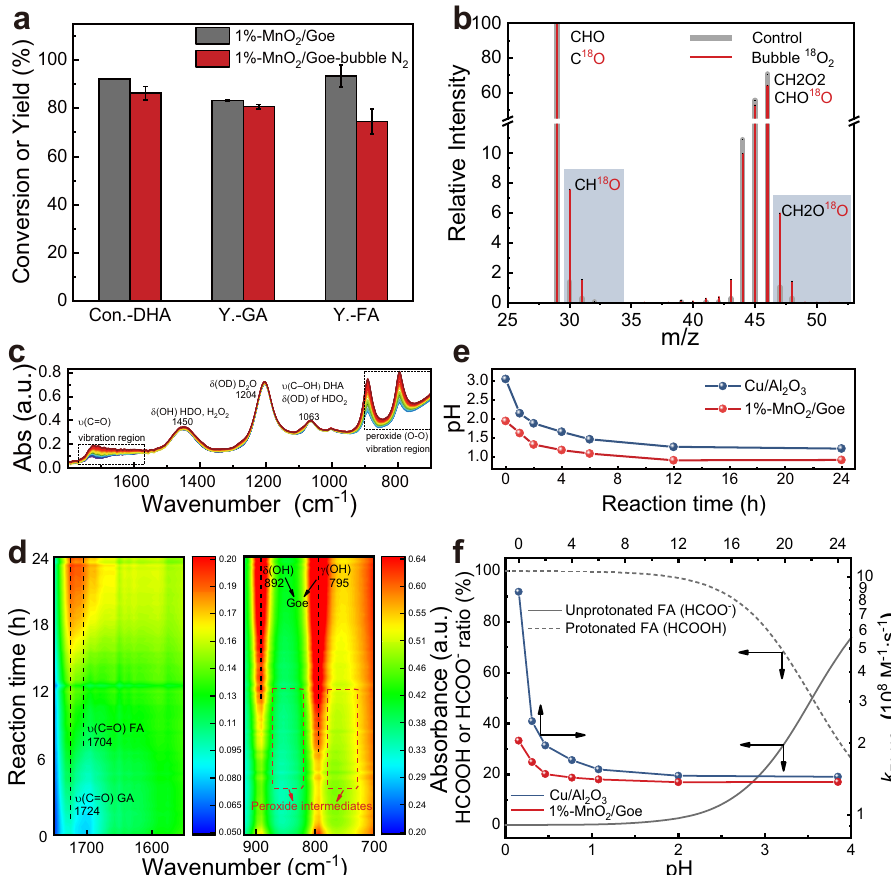
Fig. 6 FA formation investigations. a Effect of bubbling N 2 on the activity of MnO 2 /Goe catalyst. Error bars represent standard deviations from triplicate experiments. b MS signals of FA and its fragments during conversion of DHA with/without bubbling 18 O 2 . c , d Operando ATR-FTIR spectra during conversion of DHA in D 2 O and the corresponding carbonyl bond and organic peroxide bond vibration regions. e , f Variation in pH during the reaction process using 1%-MnO 2 /Goe and Cu/Al 2 O 3 catalysts and the corresponding protonated/unprotonated FA ratio with the change of pH value and the calculated average intrinsic rate constants of FA with HO·. The calculation of the ratio and average intrinsic rate constants were described in SI. The preparation and reaction conditions of Cu/Al 2 O 3 were the same as that in the literature 13